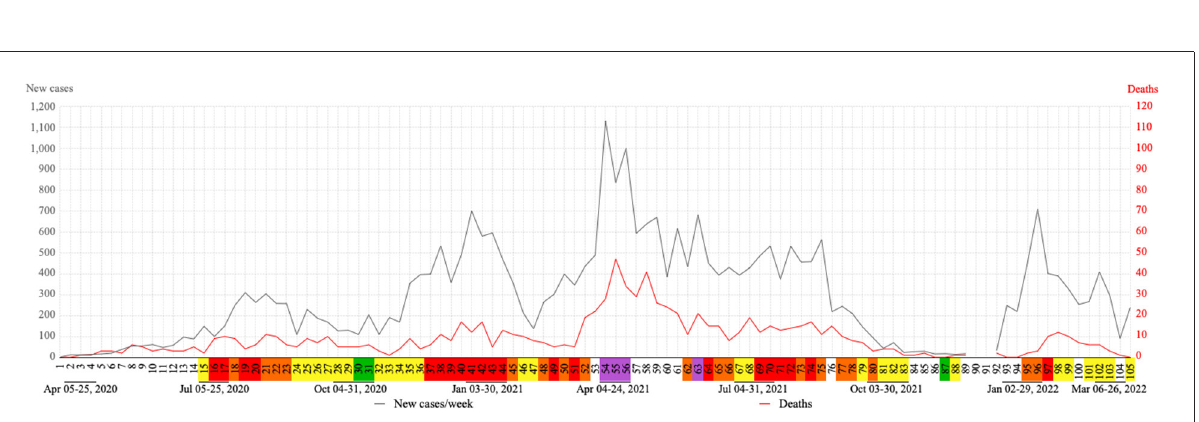
FIGURE4 Evolution of weekly COVID-19 cases and deaths in Nova Friburgo. Flag colors: Green, very low; yellow, low; orange, moderate; red, high; purple, very high risk.